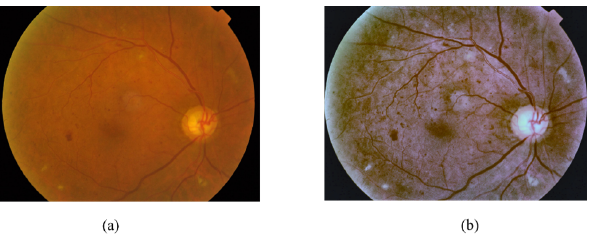
Figure 7. Sample images of the ( a ) original image and ( b ) the preprocessing image.